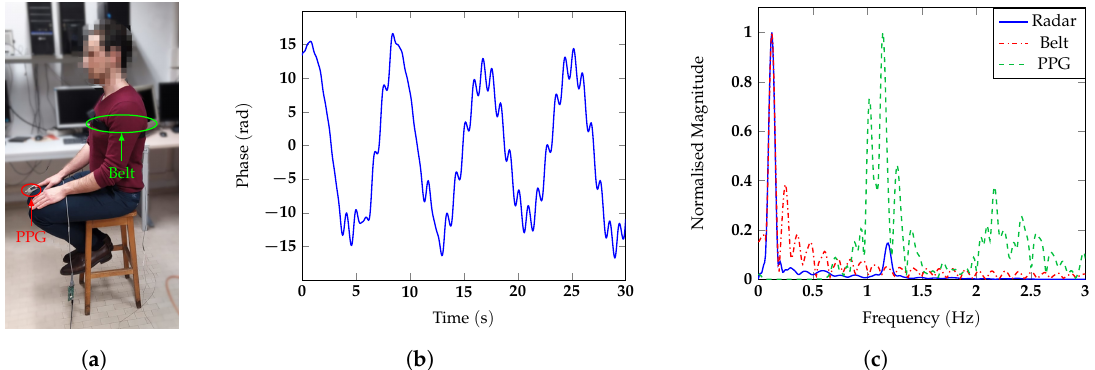
Figure 8. ( a ) Photo of the experimental setup in which the left side of the subject is facing the antenna; ( b ) vital signs extracted by the radar in the time domain and ( c )